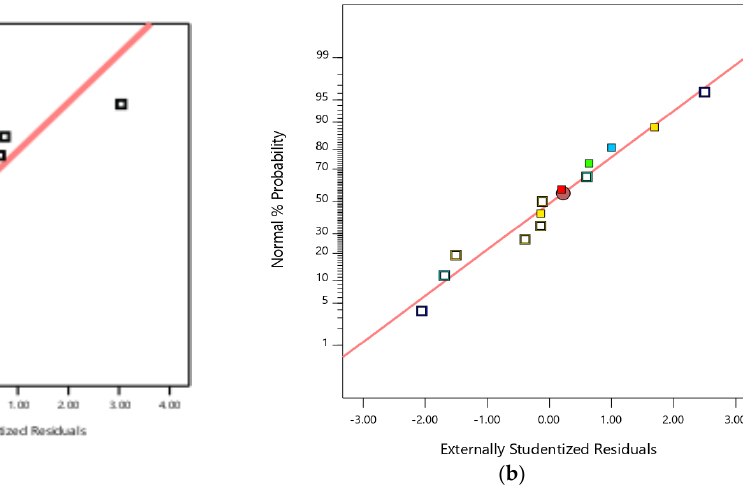
Table 9. Validation of model terms for responses.